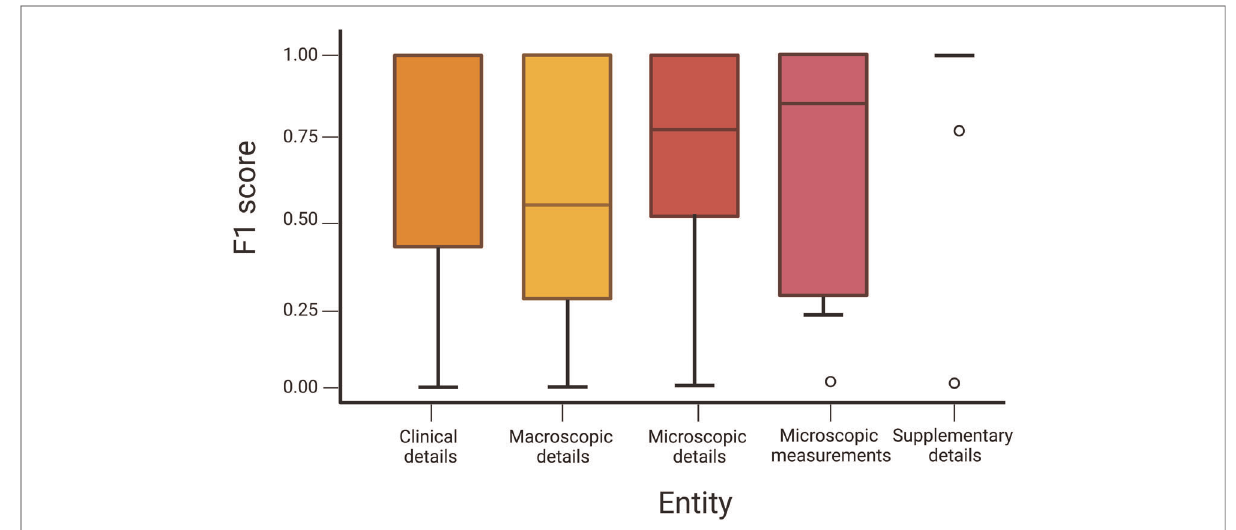
FIGURE 3 Boxplot of an F1 score across entities demonstrating variance with 95% con fi dence